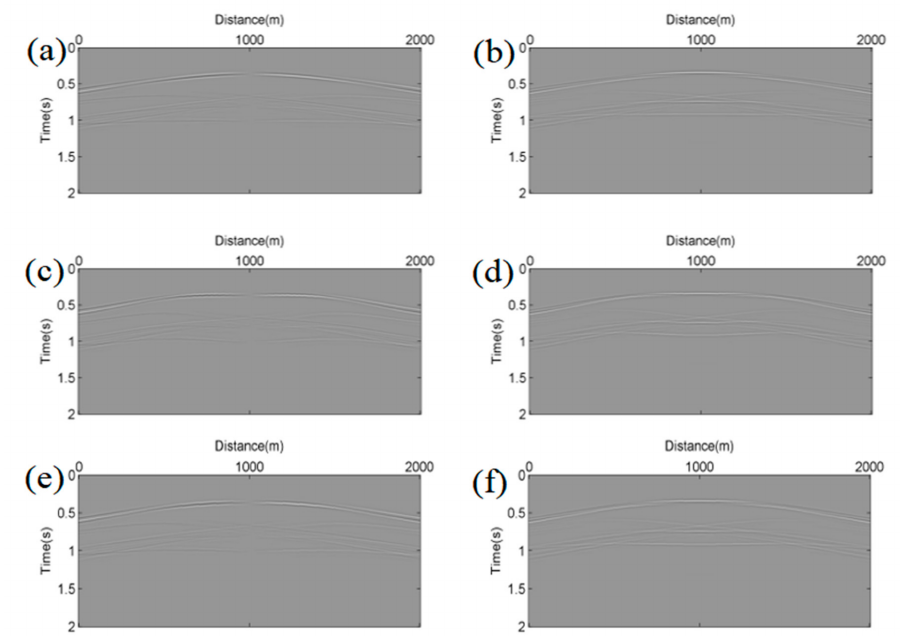
Figure 9. The noise-free common-shot gathers for graben elastic models with different topographies. The left panels are the horizontal component common-shot gathers, and the right panels are the vertical component common-shot gathers. The direct arrivals were removed. Panels ( a , b ) are the common-shot gathers for graben elastic model with a horizontal topography, panels ( c , d ) are the common-shot gathers for graben elastic model with a sinusoidal topography, and panels ( e , f ) are the common-shot gathers for graben elastic model with a triangular